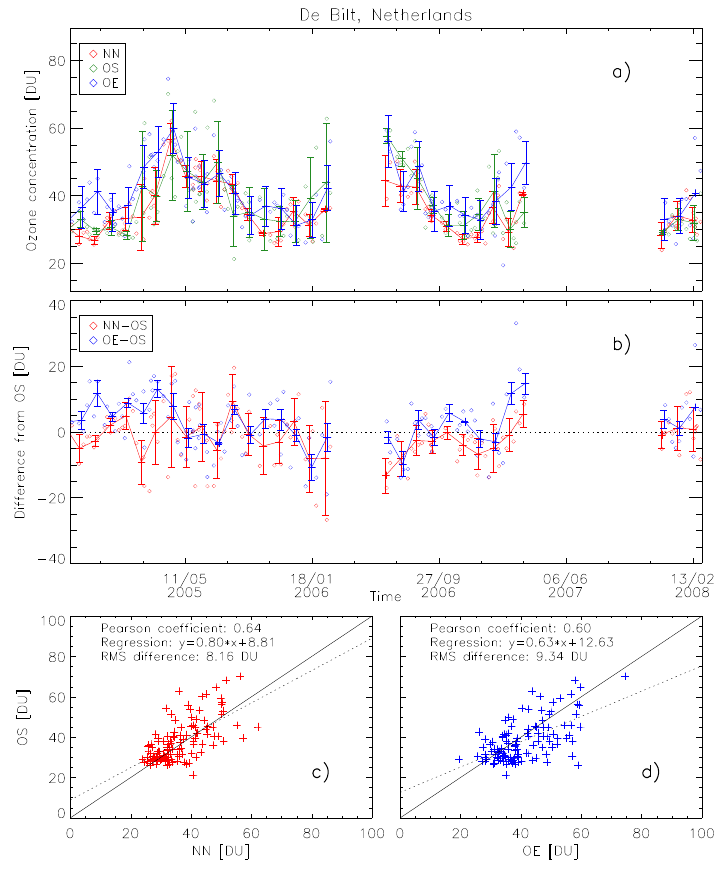
Fig. 7. Time series of OMI-TOC NN (in red) and OE (in blue) retrievals, and OS reference data (in green) (a); time series of absolute differences between OMI-TOC NN retrievals and OS (in red), and OE retrievals and OS (in blue). A monthly mean is over plotted (crosses with errorbars and lines) (b); scatter plot of OMI-TOC NN retrievals (in red) and OE (in blue) versus corresponding OS true data (c,d) for De Bilt, Netherlands.